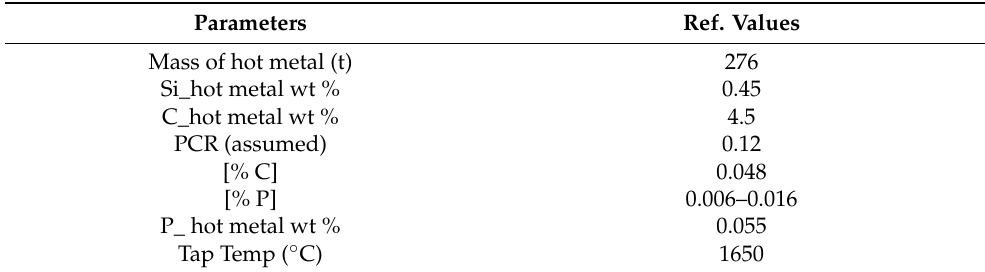
Table 2. Reference values considered for sensitivity analysis.